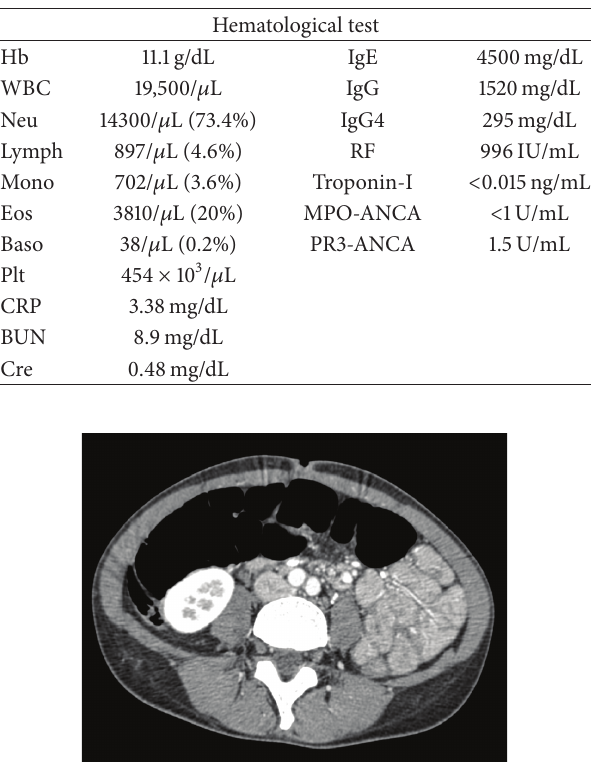
Figure 1: Contrast-enhanced abdominal computed tomography demonstrating small intestine wall thickening with fluid